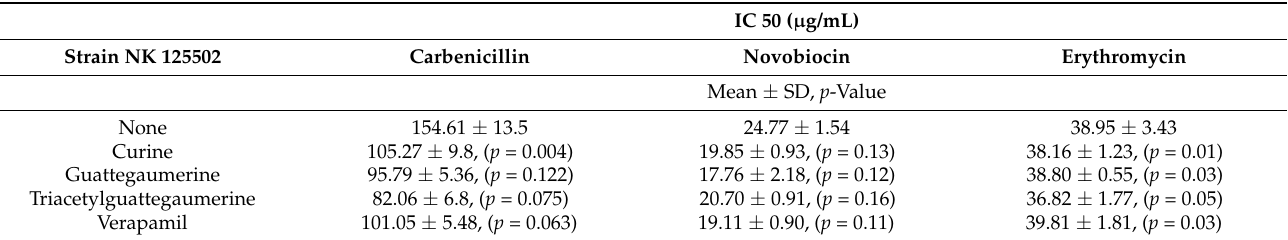
Table 2. IC50 of P. aeruginosa NK125502 for carbenicillin, novobiocin, and erythromycin in the presence or absence of